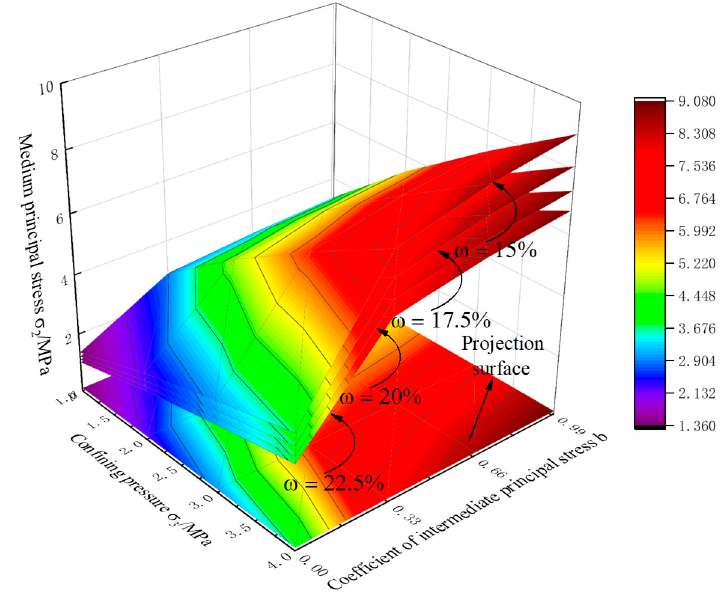
Figure 10. Three-dimensional trend chart of b value, confining pressure, and intermediate principal stress with different water contents.